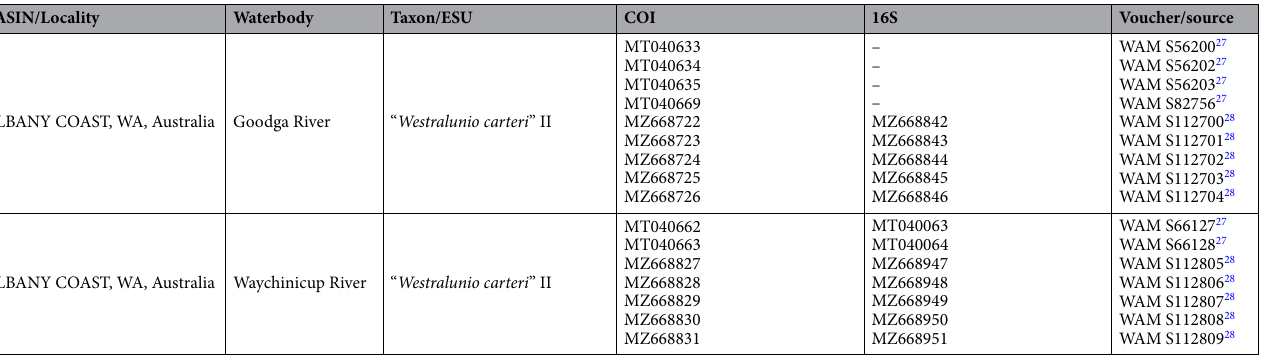
Table 3. Taxa used for phylogenetic analyses. Specimen provenance, GenBank accession numbers for mitochondrial Cytochrome c Oxidase Subunit I (COI) and 16S rDNA (16S) gene sequences, and voucher codes (in reference to source publications) are provided. Institution codes: FMNH Field Museum of Natural History, Chicago, Illinois, USA; UMMZ University of Michigan Museum of Zoology, Ann Arbor, Michigan,